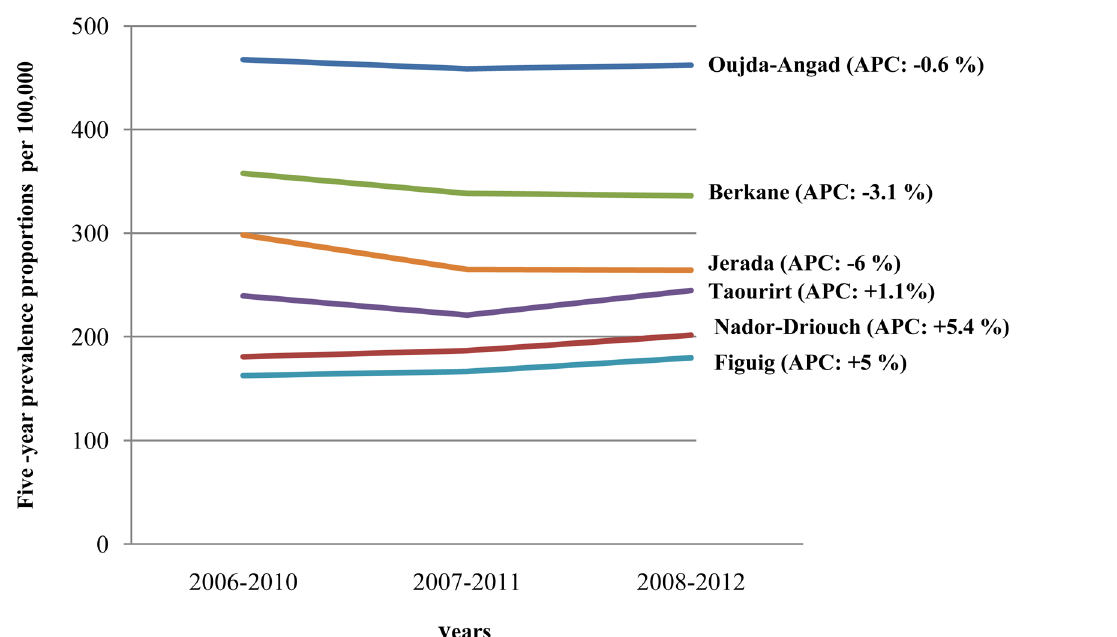
Fig 4. Trends in the five-year prevalence proportions by area of Eastern